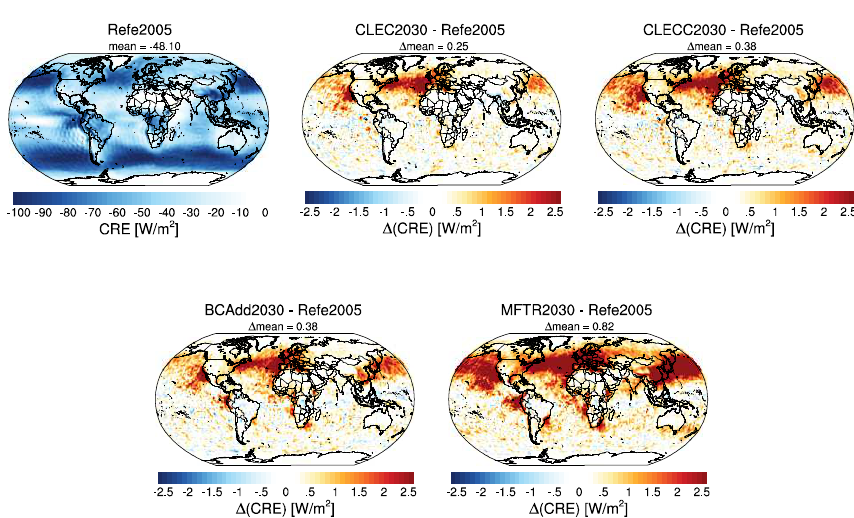
Figure 6. The yearly mean cloud radiative effect (CRE) at the top of the atmosphere in the reference run and the difference between scenarios and the reference